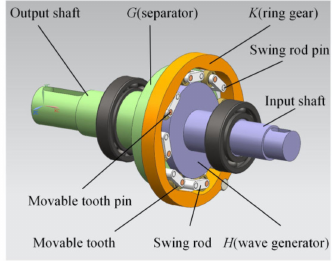
Figure 1. The two-tooth difference swing-rod movable teeth transmission